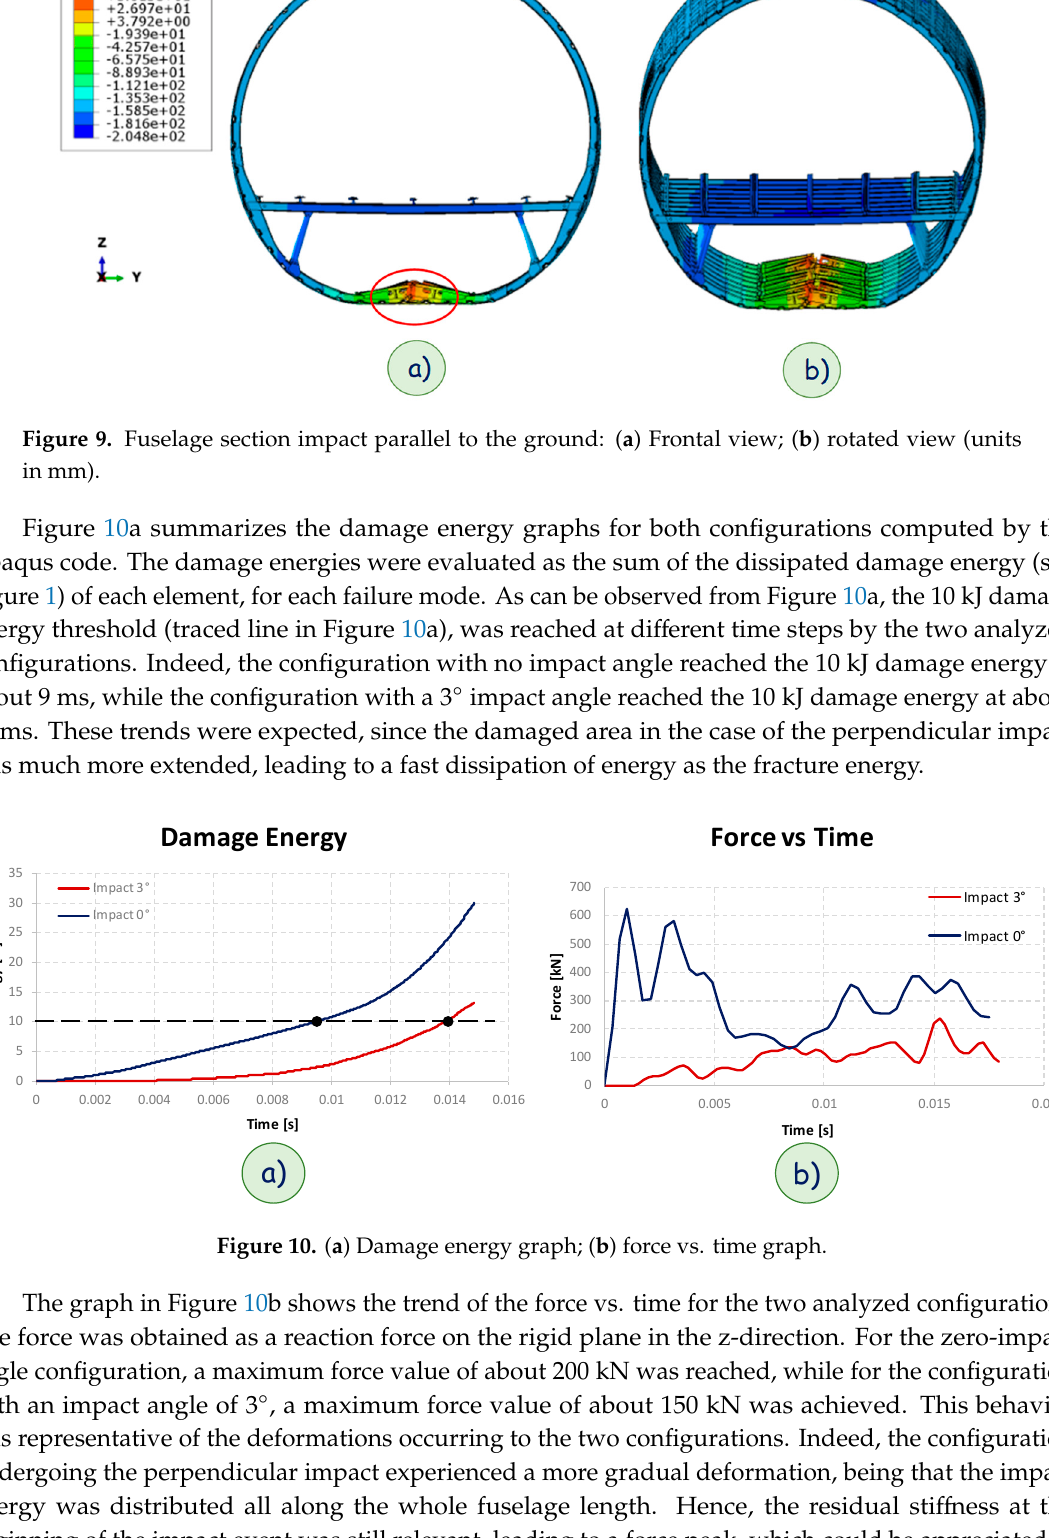
Figure 9. Fuselage section impact parallel to the ground: ( a ) Frontal view; ( b ) rotated view (units in mm).